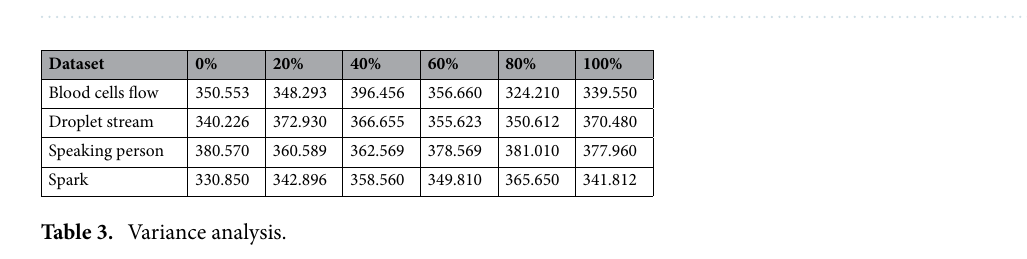
Figure 10. Histograms of the ( a , b ) speaking person, ( c , d ) blood cells, ( e , f ) droplet flow and ( g , h ) sparks data sets for encrypted and compressed formats (top row) and a single frame from data set (bottom row).